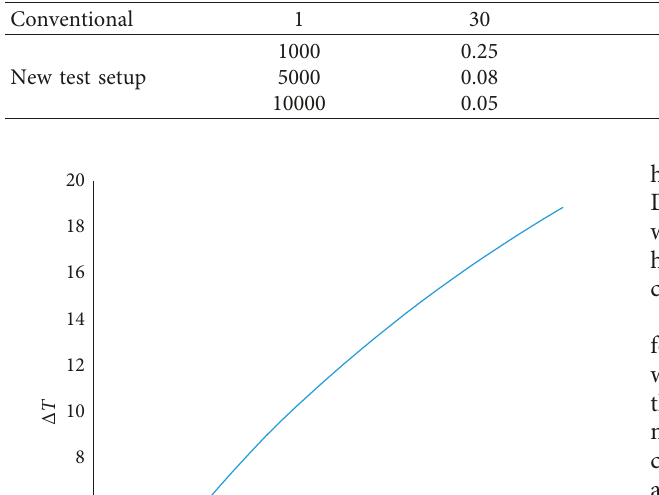
Figure 6: The drag force against the clamp movement. Table 3: The maximum temperature increase in the rubber specimen due to the heat build-up during the test. DMA test device